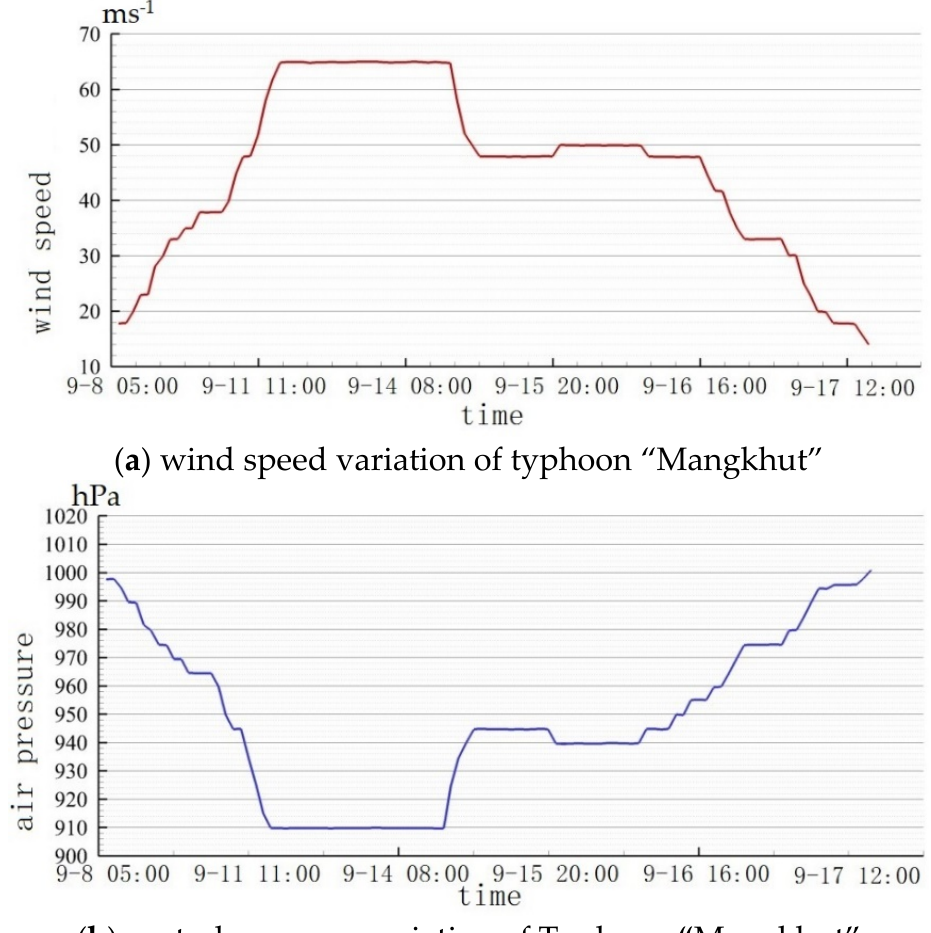
Figure 9. Wind speed and air pressure in the center of Typhoon “Mangkhut” (data of Typhoon “Mangkhut” according to Liu [28]).